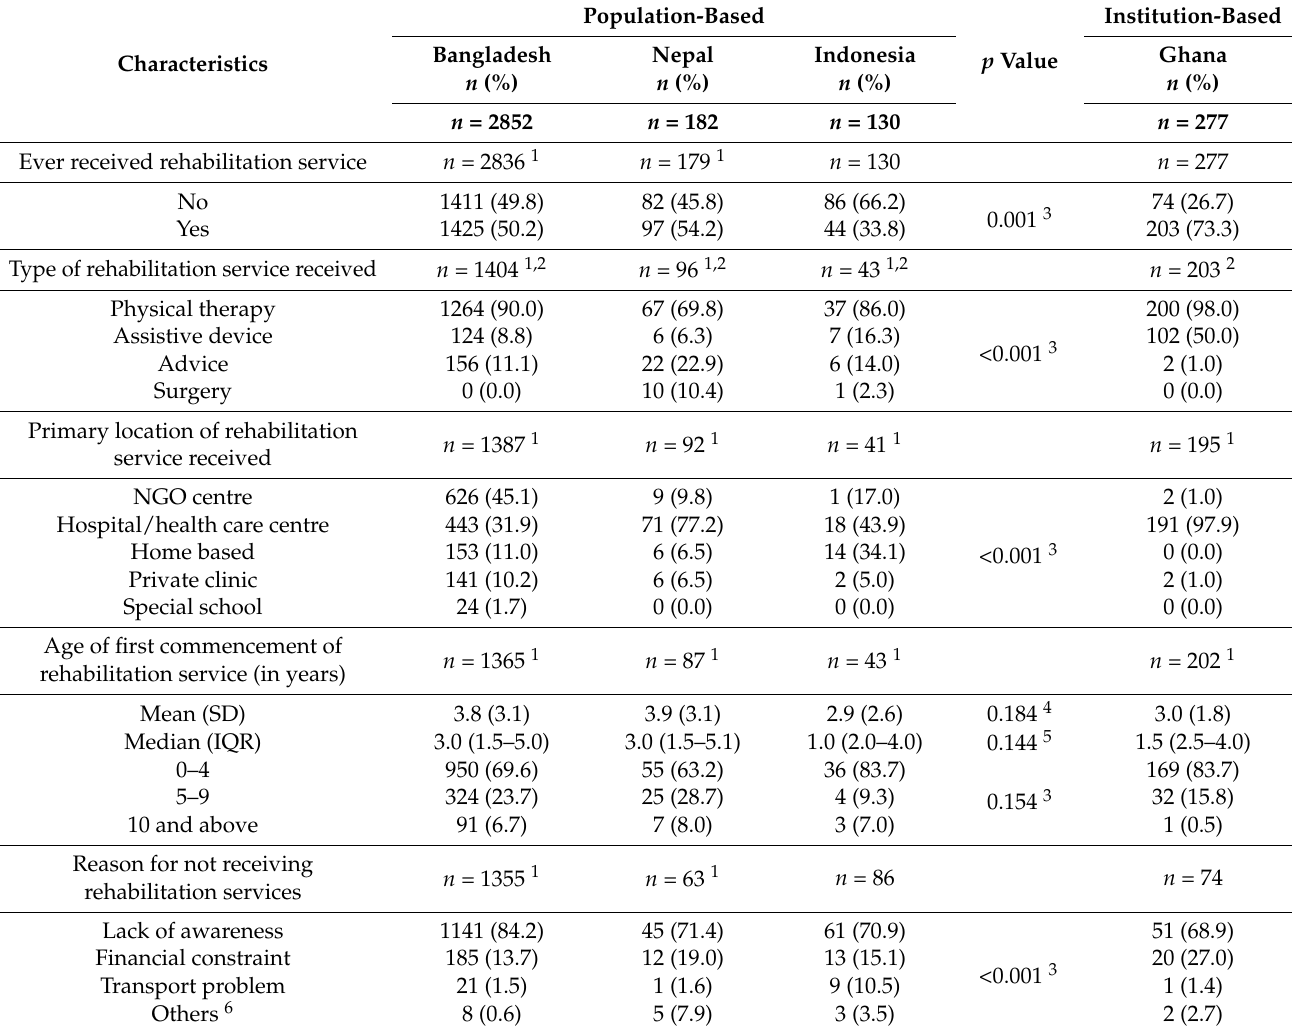
Table 1. Rehabilitation status of children with CP in Bangladesh, Nepal, Indonesia, and Ghana.